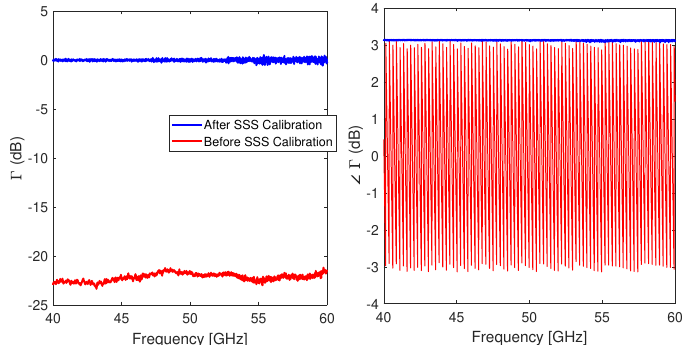
Figure 4. Experimental reflection coefficient values in magnitude and phase ofa 2 cm 2 metallic plate as a function of microwave frequency before and after SSS calibration ( θ 0 = 28 ◦ and D = 50 cm)